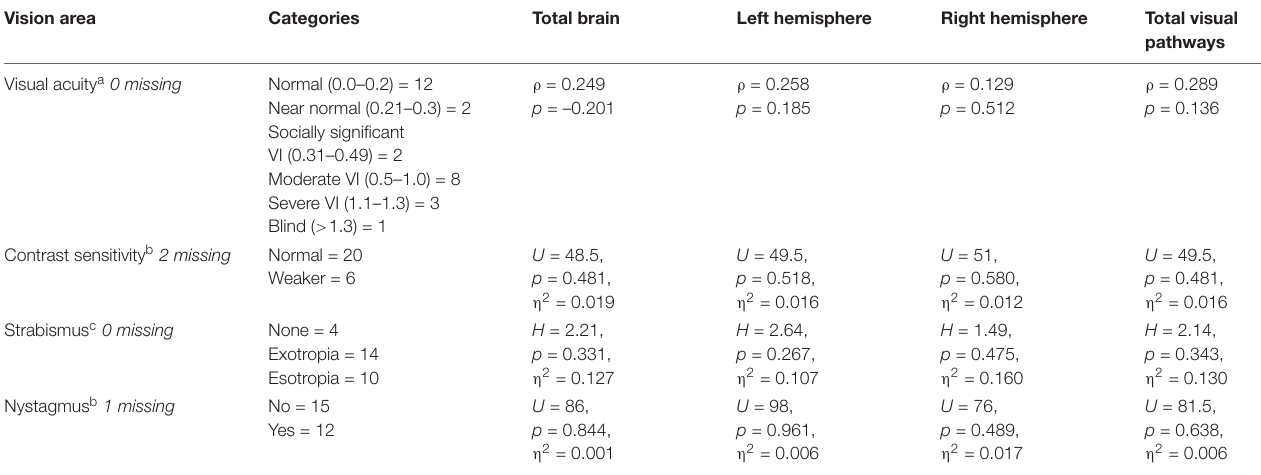
TABLE 3 | Comparisons of brain summary scores with vision/eye variables. Vision area Categories Total brain Left hemisphere Right hemisphere Total visual